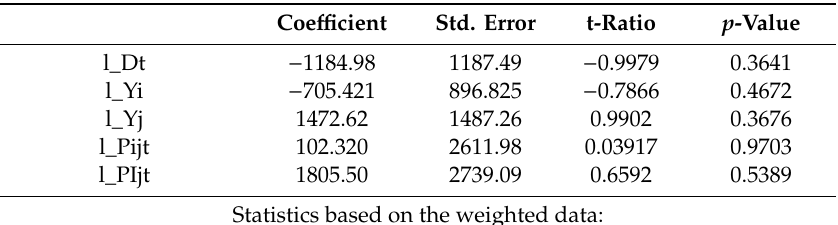
Figure 2. The most popular destinations among Croatian tourists [39]. Table 4. Feasible generalized least squares (FGLS) estimation of the total amount of Croatian tourists in Hungary—general model. Model 1: FGLS, using observations 2009–2018 (T = 10); dependent variable: TAij; variable used as weight: